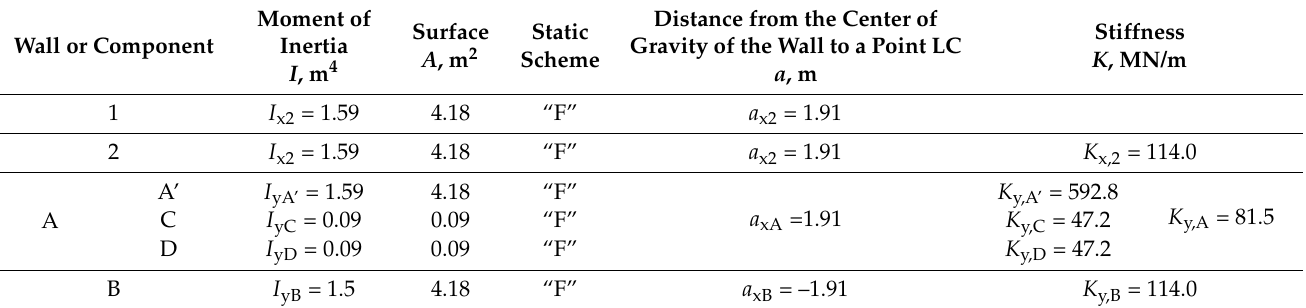
Table 8. Geometric and stiffness characteristics of walls.